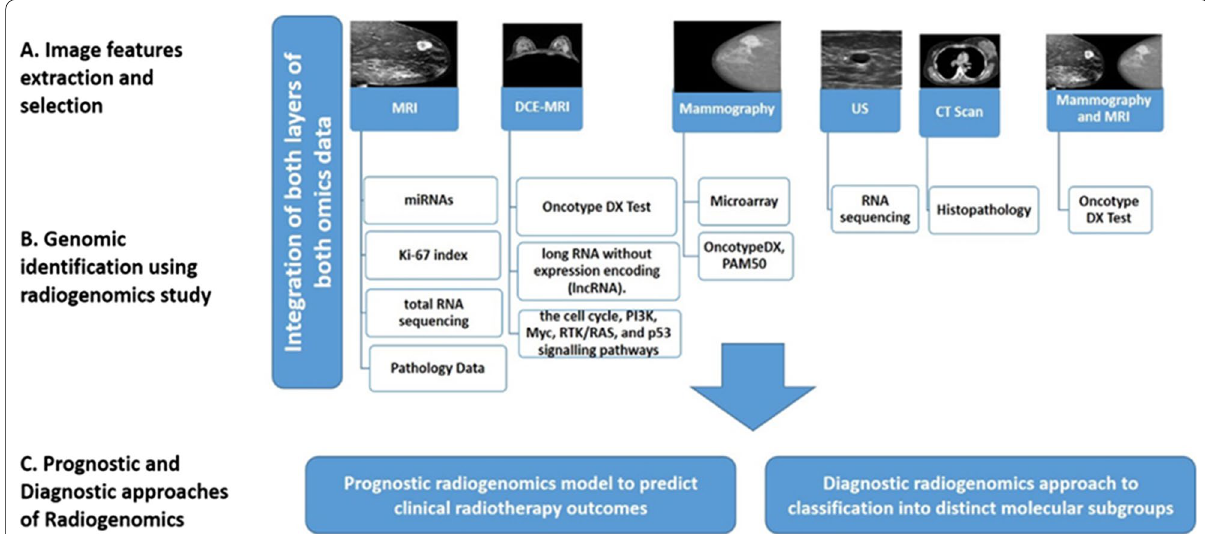
Fig. 2 Typical workflow of radiogenomics studies in breast cancer patients. A Image features extraction and selection. B Genomic identification using radiogenomics study. C Prognostic and diagnostic approaches of